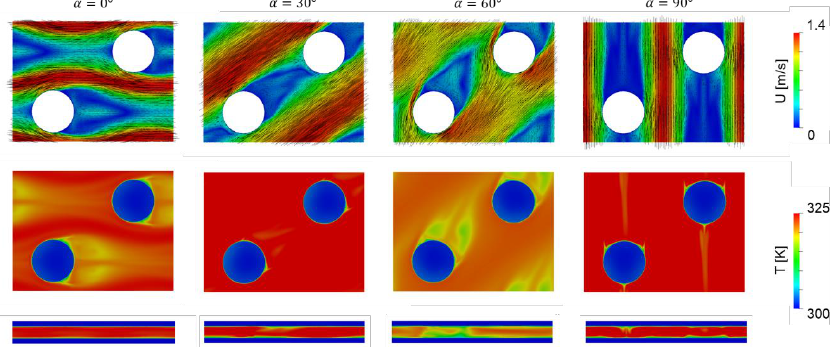
Figure 12. Dimple-type turbulator: Detail of the flow field with average velocity U = 0.5 m/s.